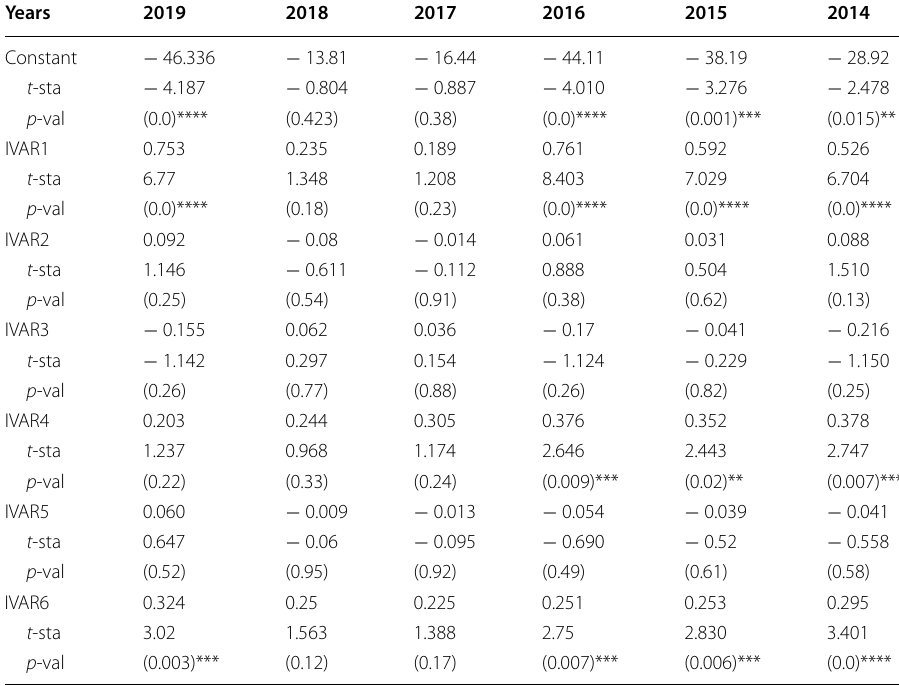
****, ***, ** and * denote statistical significance at the 0.1%, 1%, 5%, and 10% significance level, respectively. The table contains t ‑statistic and their corresponding p ‑values below in